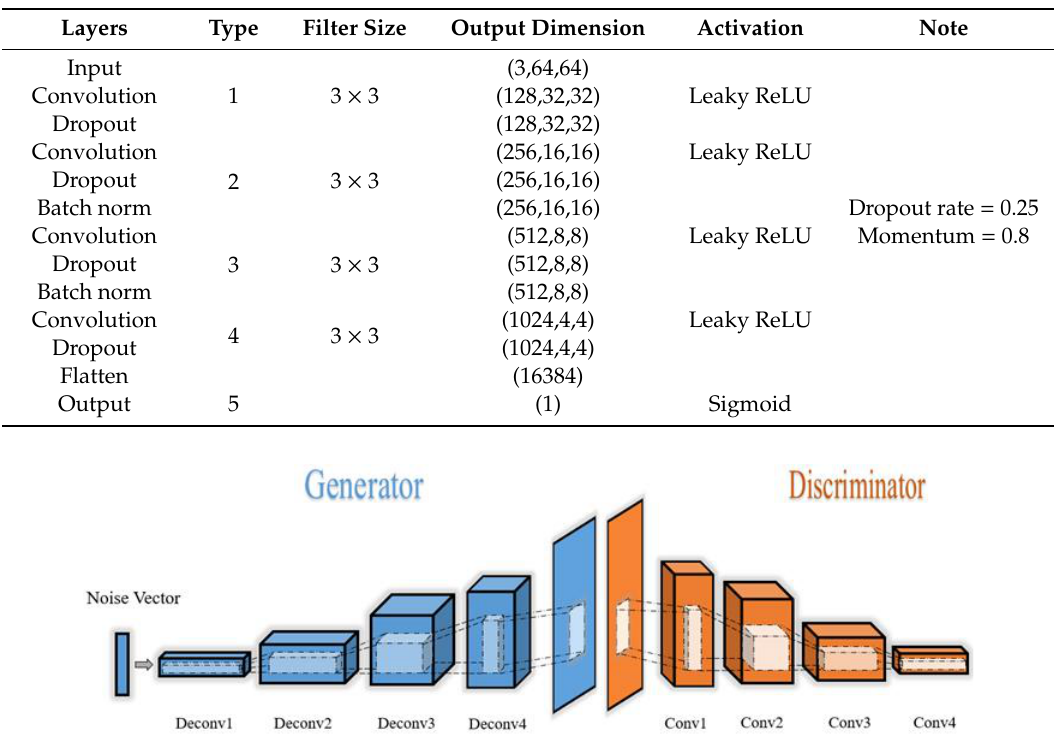
Figure 10. The structure of the deep convolutional generative adversarial network (DCGAN) model.